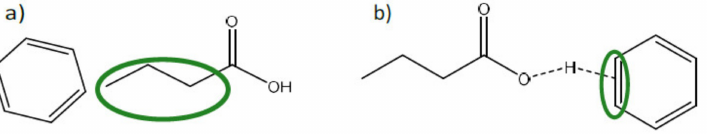
Figure 3. Possible interactions between the aromatic ring of a non-functionalized polystyrene based adsorbent and VFAs, ( a ) purely hydrophobic interactions, and ( b ) hydrogen bond–pi interactions.